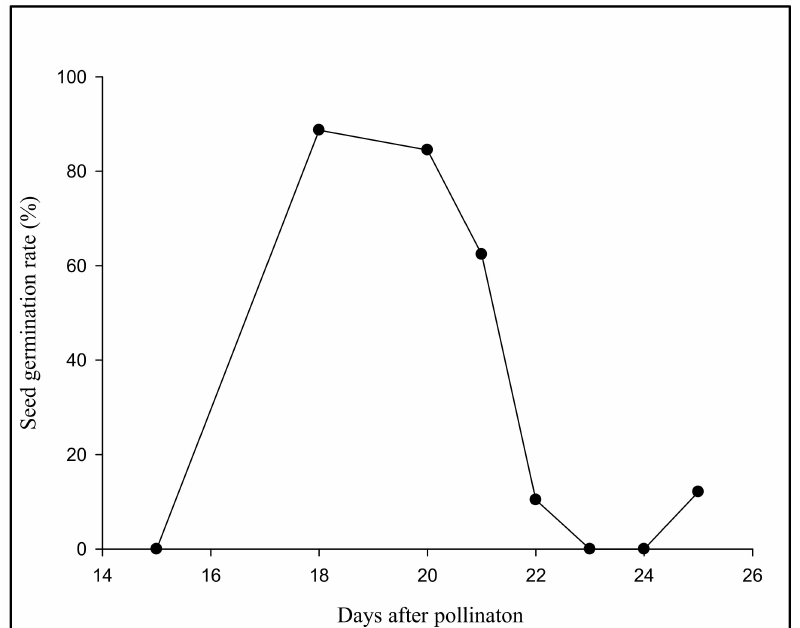
Figure 3. Changes in the germination rate of G. elata seeds after one month in culture. DAP: days after pollination (carried in March